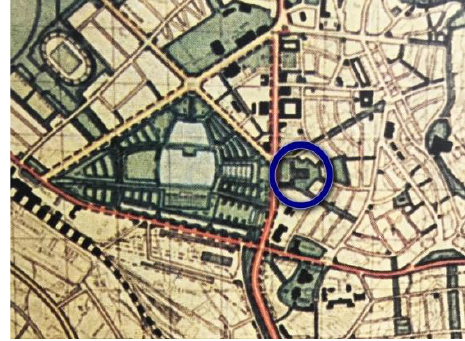
Figure 1: Partial view from the Jansen Plan (1932), taken from Sözen, M. (1984). The square was defined especially with the eastern entrance of the Gençlik Park, planned